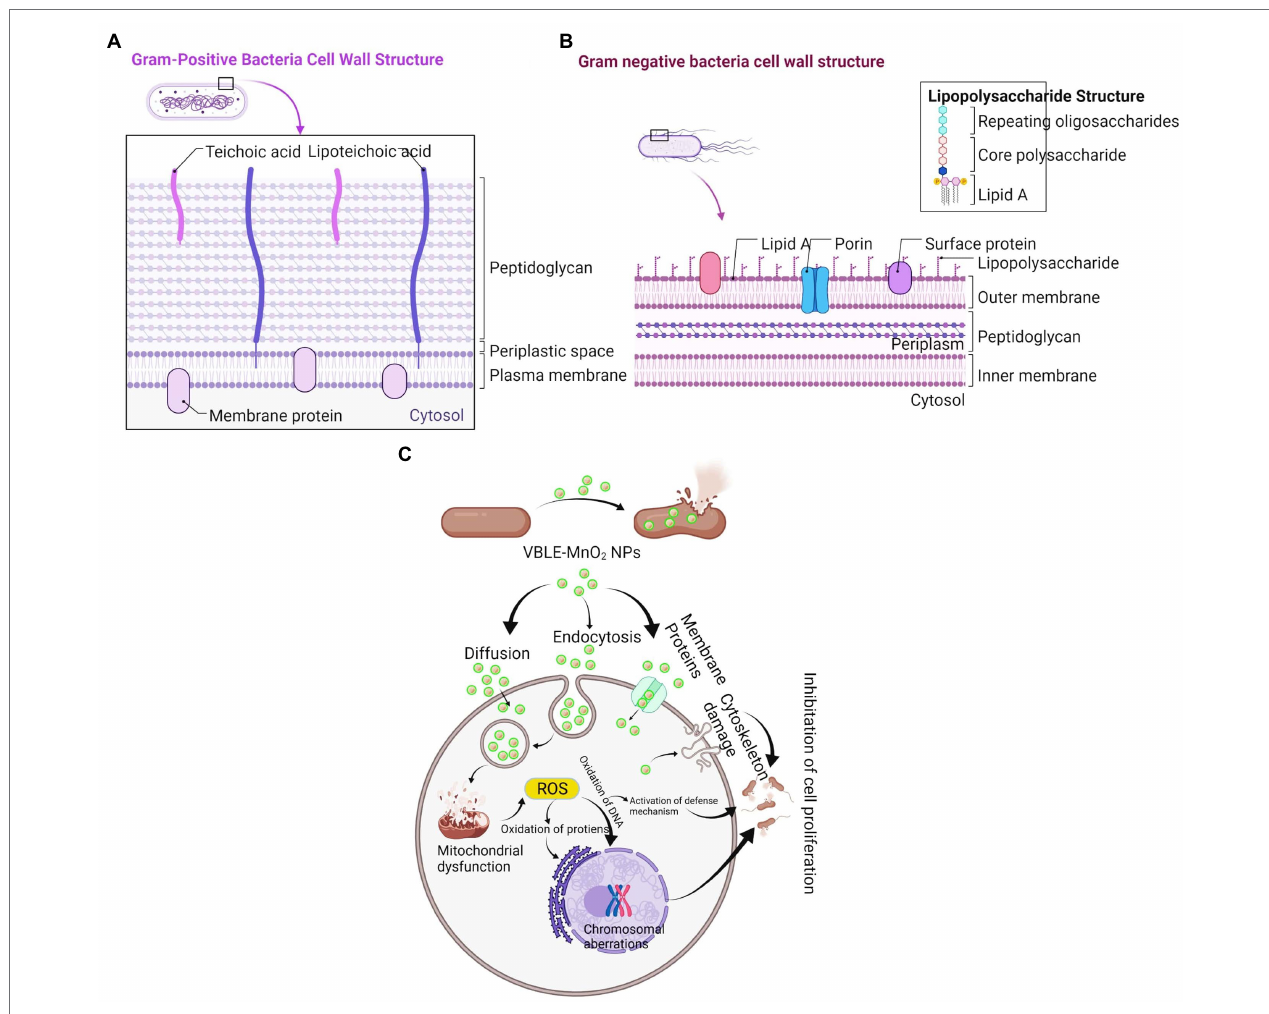
FIGURE 6 | Comparison of (A) Gram-positive and (B) Gram-negative bacterial cell wall. (C) Proposed antibacterial mechanism of green synthesized VBLE-MnO 2 NPs.